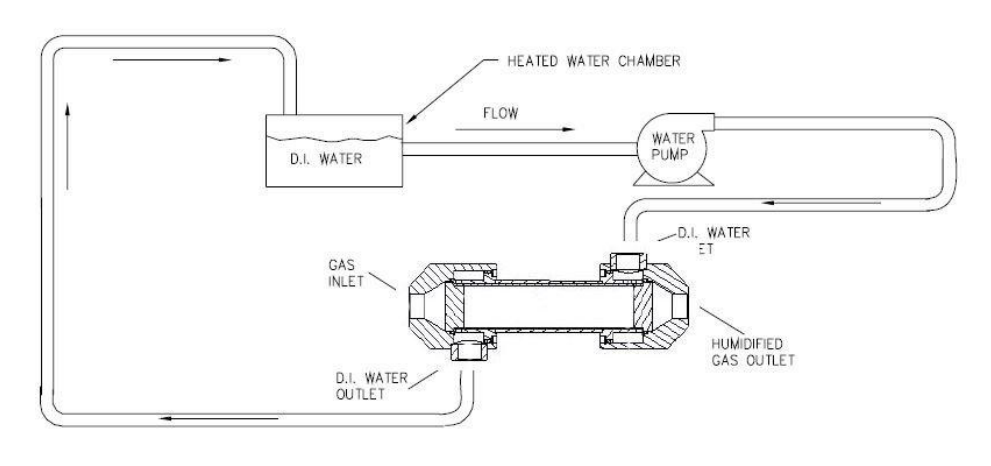
Figure 3. Water-to-gas commercial system.